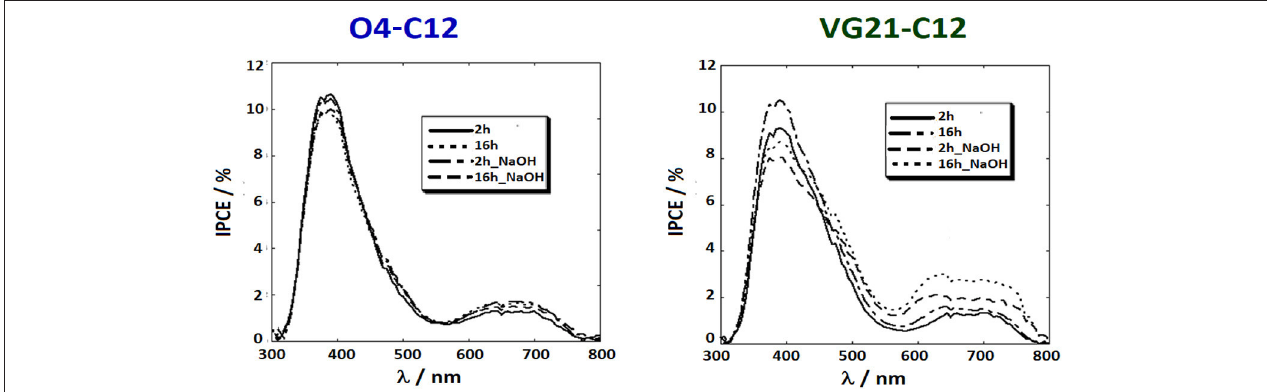
photoelectrochemical conversion efficiency for the VG21-C12- sensitized (ON) device was prevented by an anomalous V OC (i.e., 91 mV)